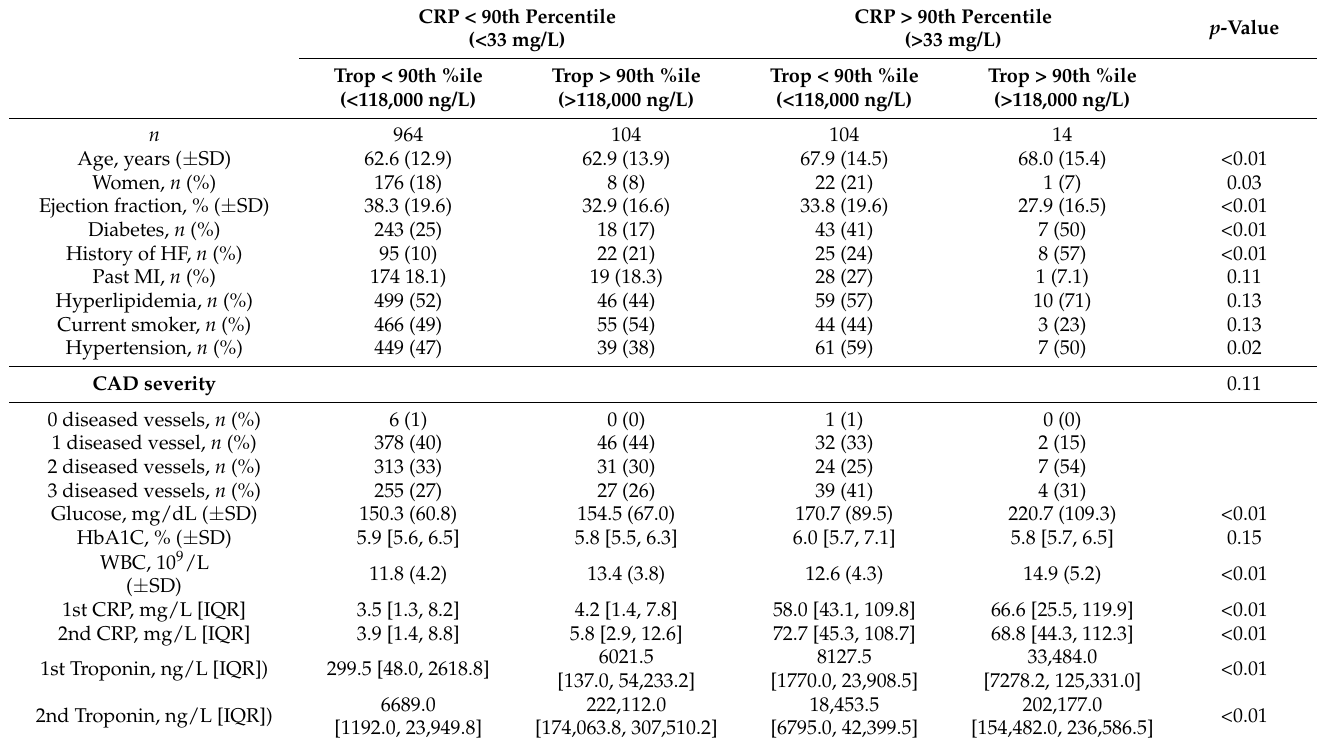
Figure 1. Combined CRP and Troponin Test (CTT) results. A scatterplot of the study population according to their second CRP and cardiac troponin test results. The dotted lines represent the 90th percentile thresholds (CRP > 33 mg/L and cardiac troponin > 118,000 ng/L) according to our CHIAD analysis as described in the Methods section. Table 1. Baseline clinical characteristics by CTT * results (total n = 1186).